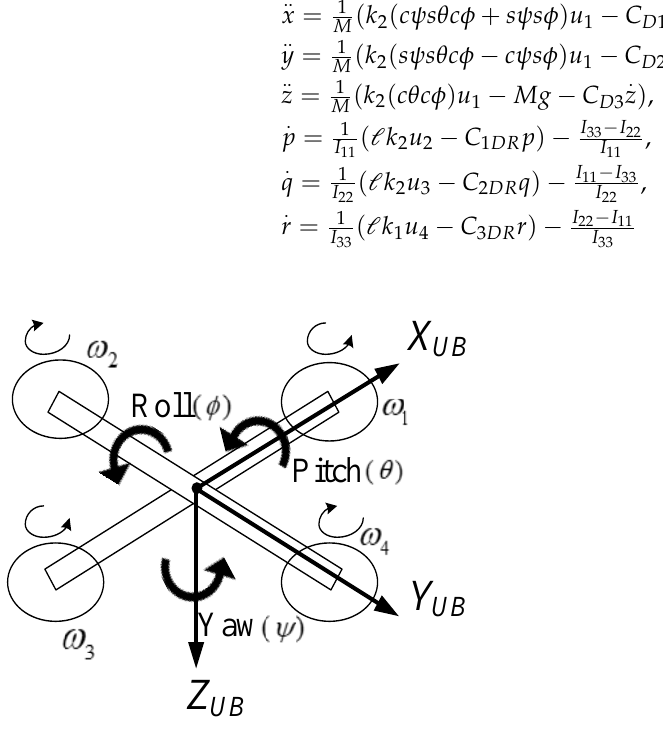
Figure 3. Schematic diagram illustrating the respective attitude angles.